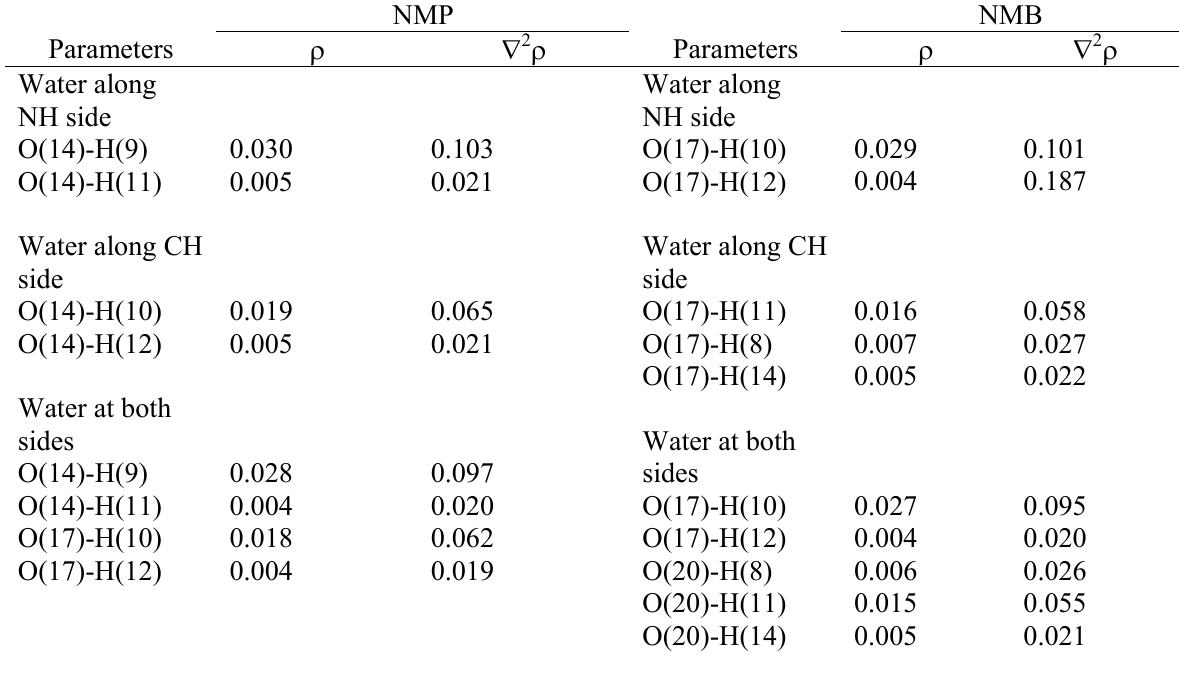
Table 5: Topological parameters ( ρ and ∇ 2 ρ in a.u) for NMP-Water and NMB-Water interactions